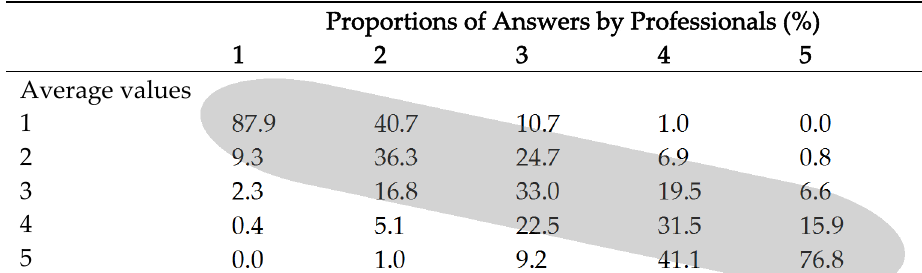
Table 1. Variations in the forest professionals’ perceptions within each class regarding the need for pre-harvest clearing of understory trees.